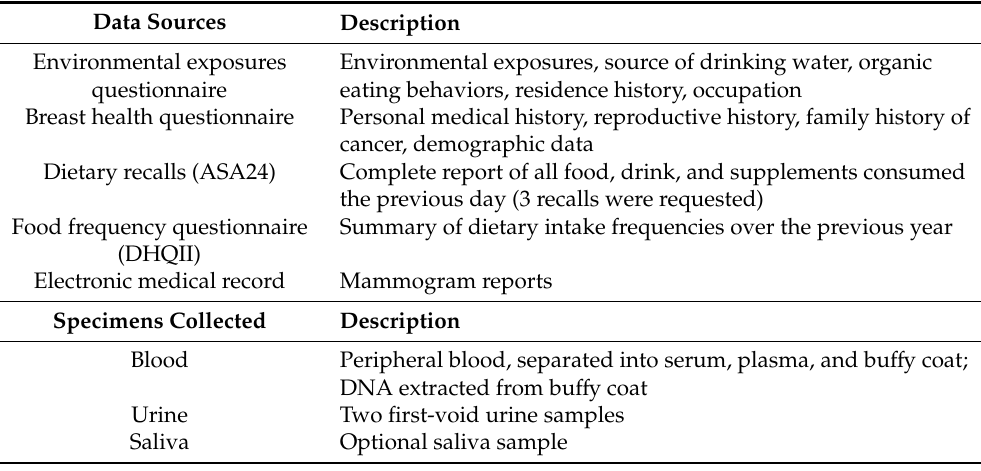
Figure 2. Study workflow. The MEE Study collected biospecimens and questionnaire-based data from 400 postmenopausal women aged 45 to 66 years residing in Southern California. Table 1. Data and specimens collected.